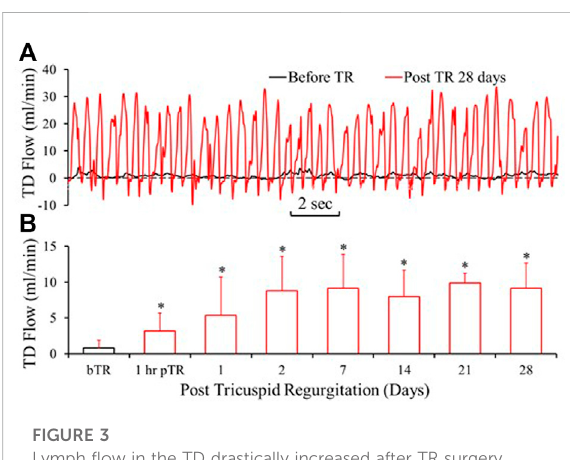
FIGURE 3 Lymph fl ow in the TD drastically increased after TR surgery. (A) Tracings of TD Lymph fl ow (TDQ) before TR surgery and 28 days post-TR surgery. (B) TDQ variation by the days of post TR surgery.bTR:BeforeTRsurgery.1hpTR:1 hpost-TRsurgery. *: p < 0.05 in comparison with bTR (before TR